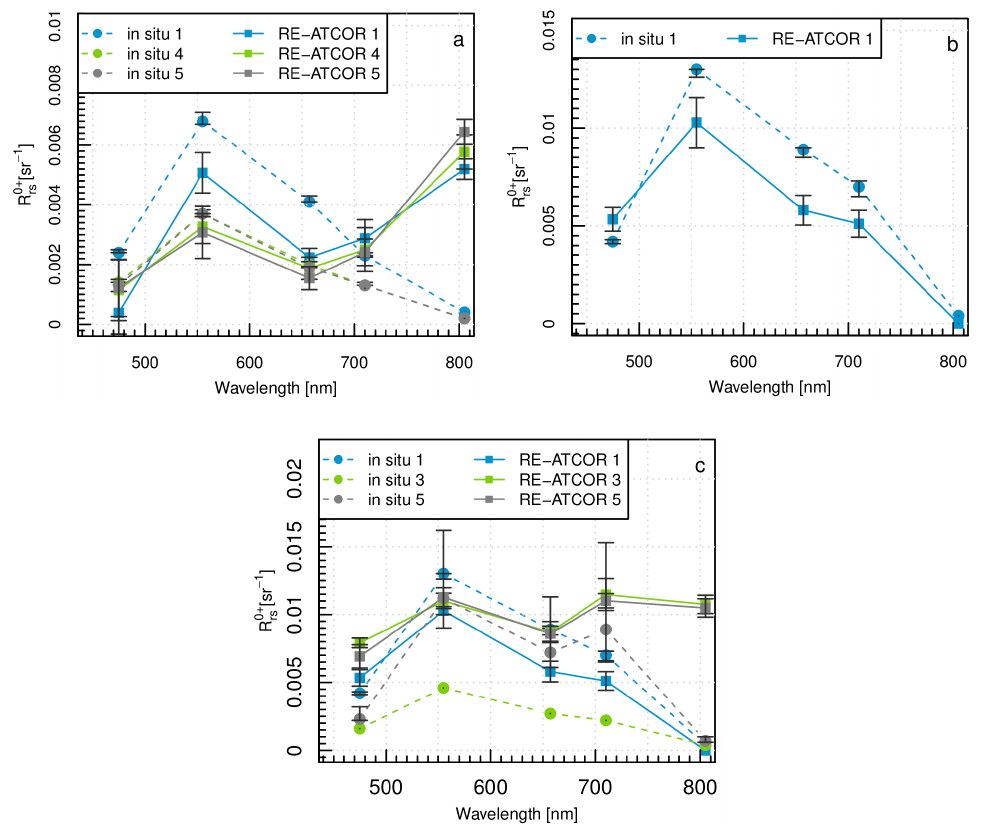
Figure 6. Comparison between resampled in situ measured median R 0 + rs ( λ ) spectra and RapidEye 5 × 5 pixel environment mean R 0 + rs ( λ ) spectra. Error bars indicate standard deviation (RapidEye) and 25% resp. 75% percentile (in-situ). ( a ) In situ data acquisition on 2 July and RapidEye acquisition on 1 July; ( b ) 1 August; ( c ) 7 August.